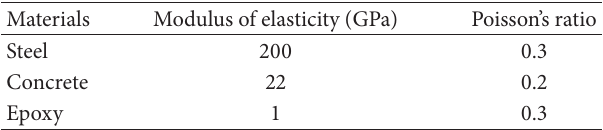
Table 1: Material properties used in finite element